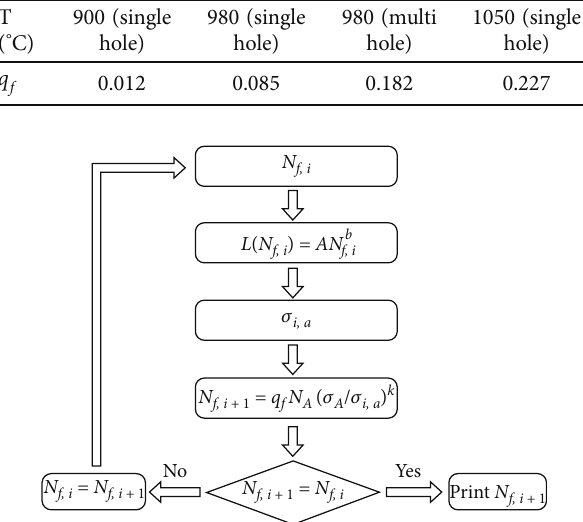
Figure 3: Flow chart of HCF life prediction by MTCD method.